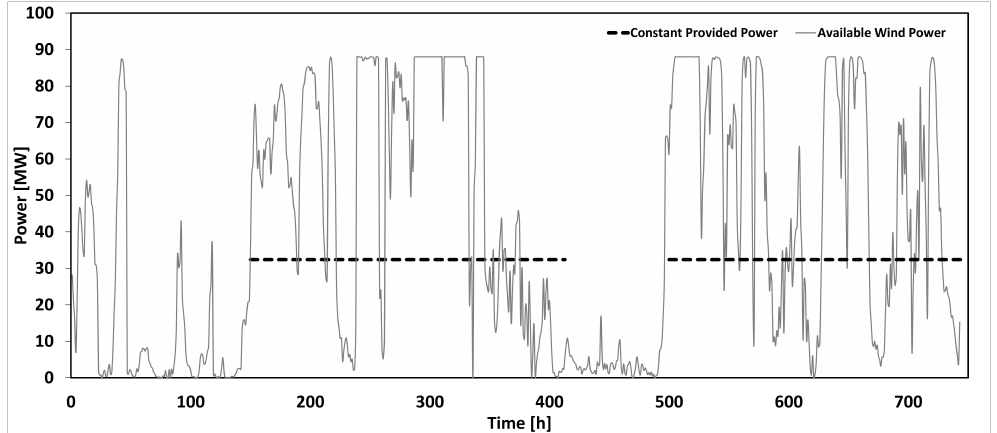
Figure 12. Constant power supply from wind